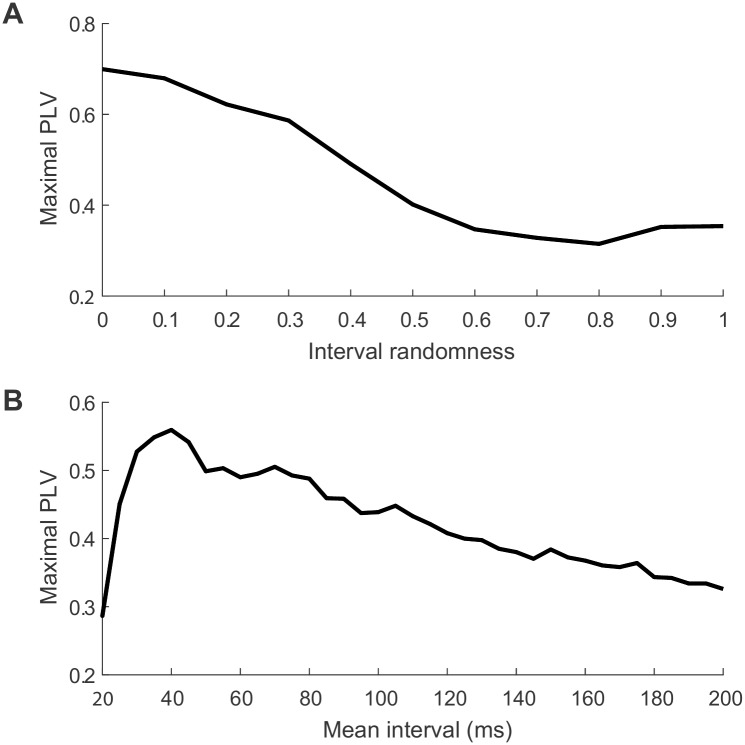
Effect of periodicity and mean interval duration on CFC.A. The magnitude of the CFC diminishes with decreasing periodicity (increased randomness). The level of CFC was defined as the maximal CFC magnitude for a 10Hz frequency-for-phase across all frequencies-for-amplitude in a 1-100Hz range. Randomness = 1: fully random; randomness = 0: completely periodic. B. CFC level depends on mean interval in a random sequence. Note that the optimal interval and exact shape of the curve will depend on the spike width (15ms Gaussian width in this example).